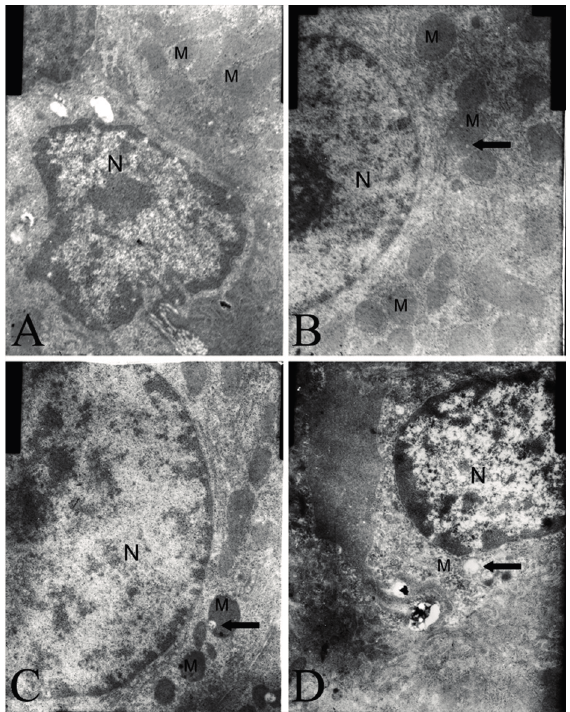
Figure 4. Mitochondrial changes in the rat liver treated with control rat ( A ), aqueous extract of EF 6 g/kg/day ( B ), 12 g/kg/day ( C ) and 24 g/kg/day ( D ) last 15 days. M mitochondria, N nucleus, the arrows showed vacuolation. Magnification